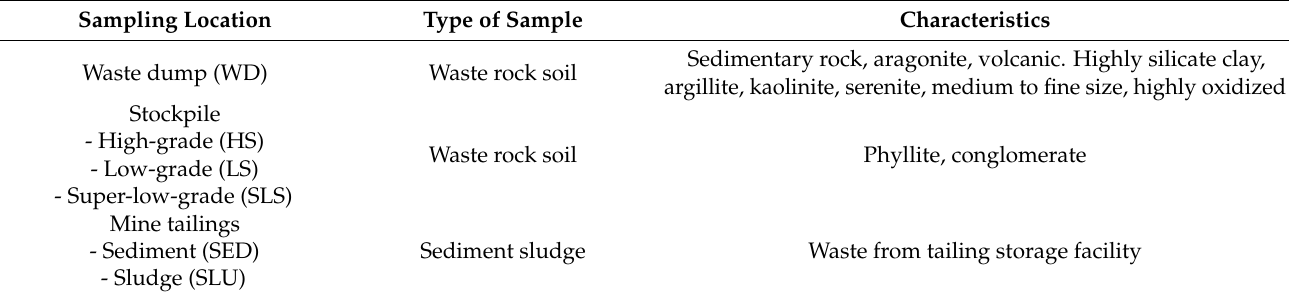
Table 1. Description of gold mine waste